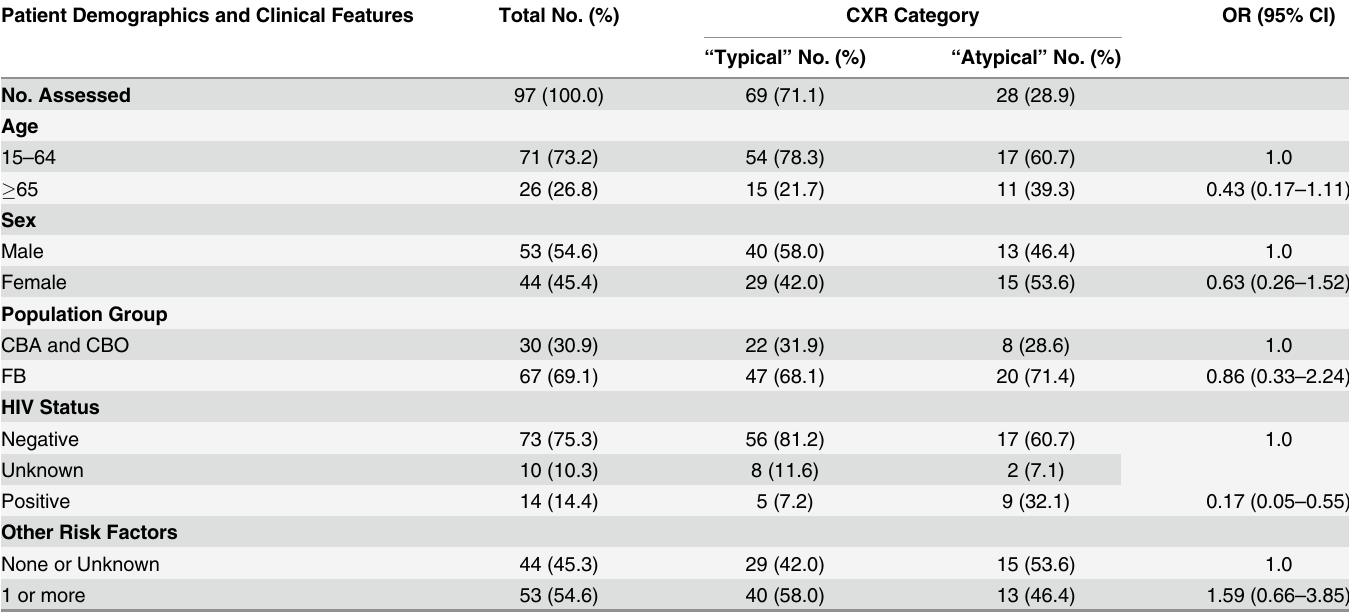
Table 2. Demographic and clinical features of smear-positive PTB patients with “ typical ” and “ atypical ” chest radiographic features. Patient Demographics and Clinical